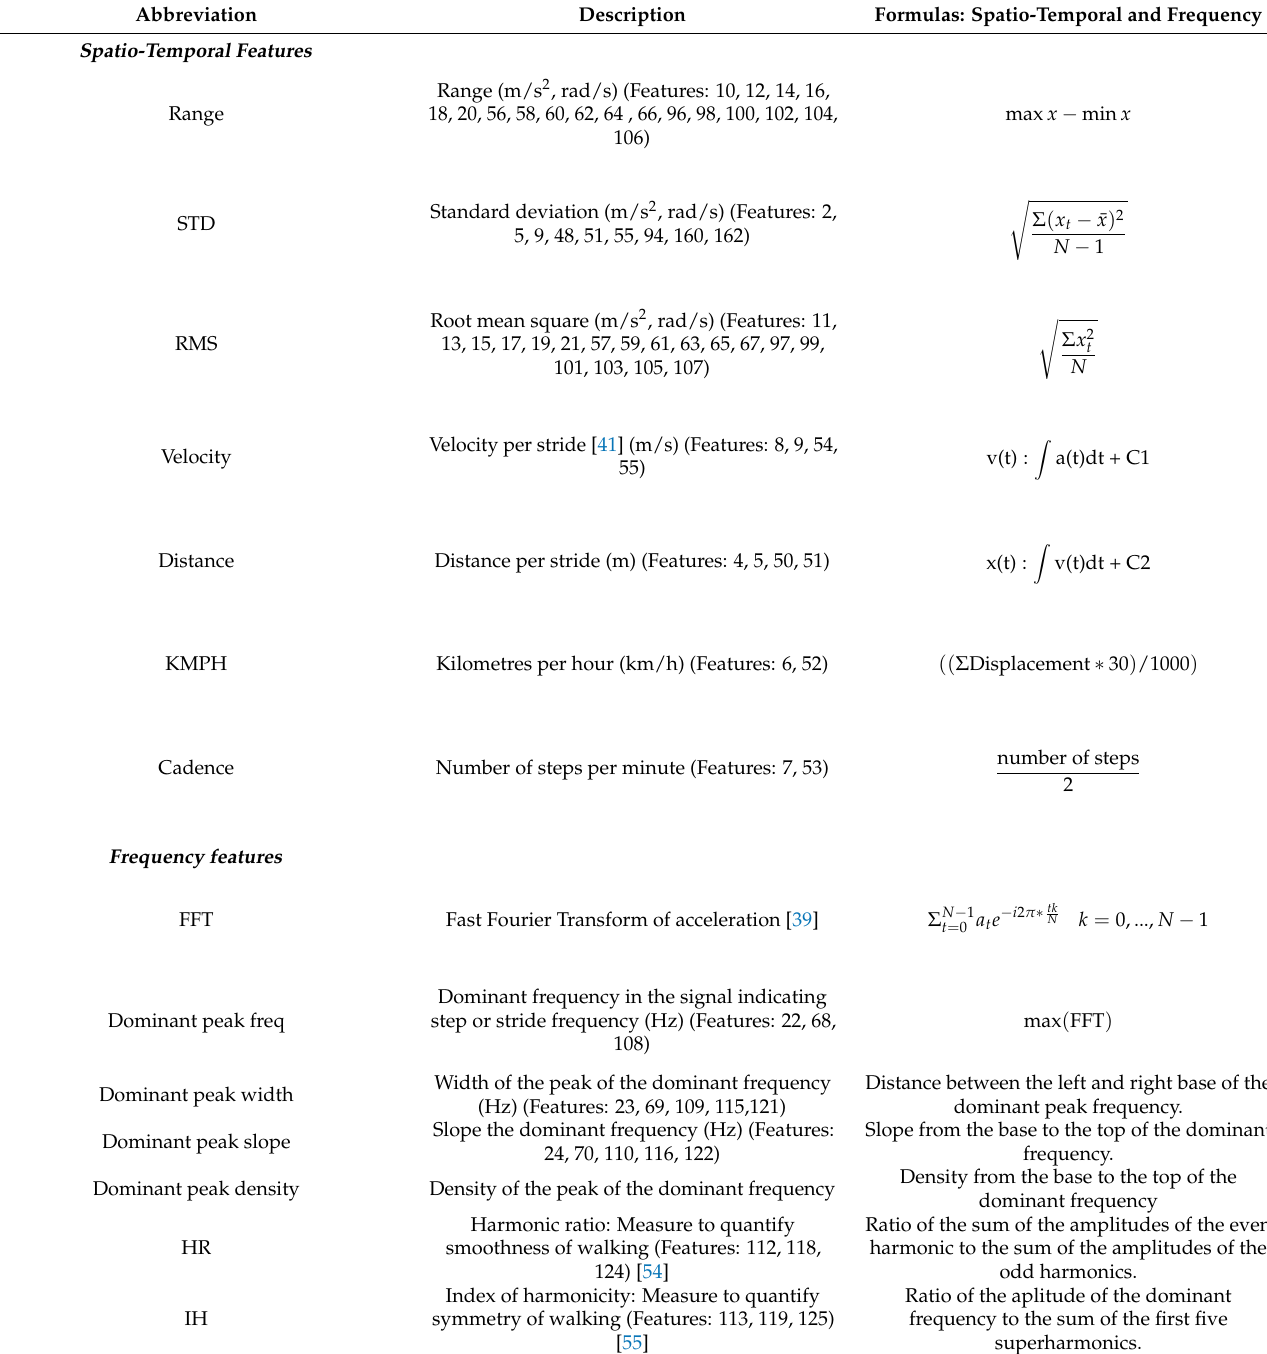
Table A3. Formulas: Spatio-Temporal and Frequency